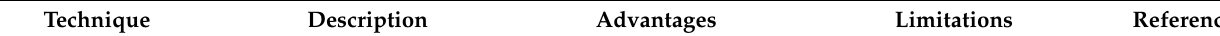
Table 3. Potential immunological assays for detection and understanding of hybrid